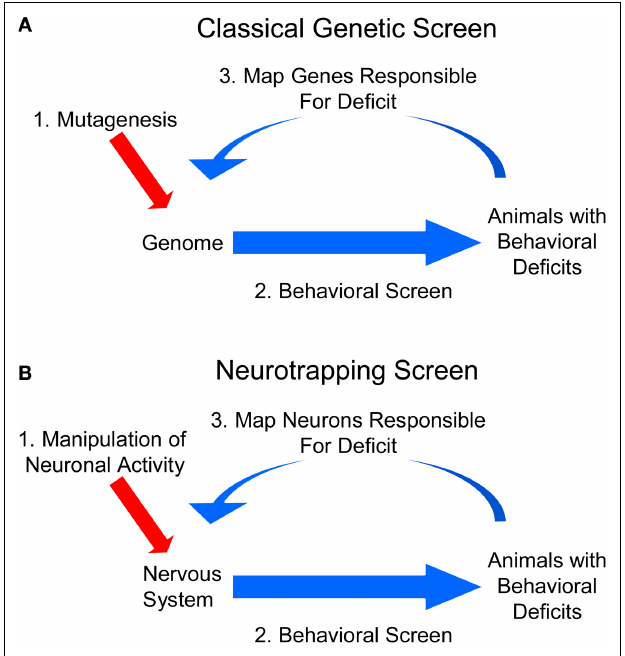
FIGURE 1 | Neurotrapping screens are analogous to genetic screens. (A) In a genetic screen, perturbations are introduced into the genome by mutagenesis, and animals bearing these mutations are analyzed for defi cits in a behavior of interest. These heritable defi cits are then traced back to the change(s) in the genetic material that are their source. (B) In a neurotrapping screen the activity of neurons, rather than genes, is perturbed. This type of screen requires genetic tools such as those listed in Table 1 for manipulating neuronal activity, and a means of targeting these tools to particular neurons. Unlike traditional methods of circuit-mapping, neurotrapping identifi es the functional components of a neural network without knowledge of synaptic connectivity (which often represents only part of a neuron’s signaling capacity) or response properties (which may only coincidentally correlate with performance of a particular